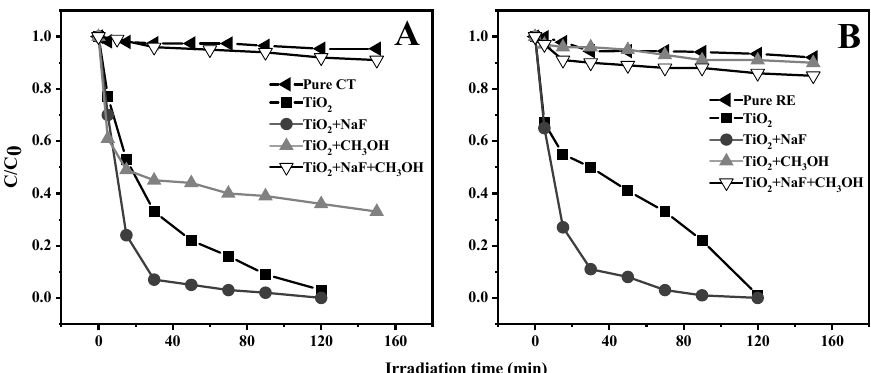
Figure 2. Comparison of CT ( A ) and RE ( B ) photocatalytic degradation performance in the presence of different scavengers ([NaF] =5 mM, CH 3 OH 5% ( v / v ), pH 4.5).